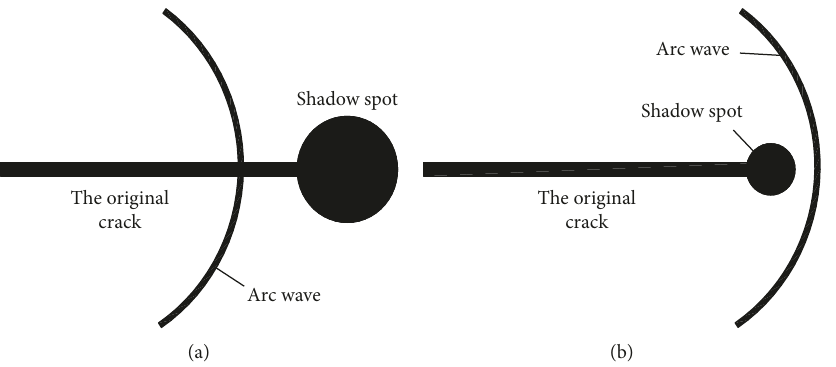
Figure 6: Macroscopic sketch diagram of the crack growth. (a) Macroscopic characteristic of the crack growth process. (b) Macroscopic characteristics of the crack arrest.